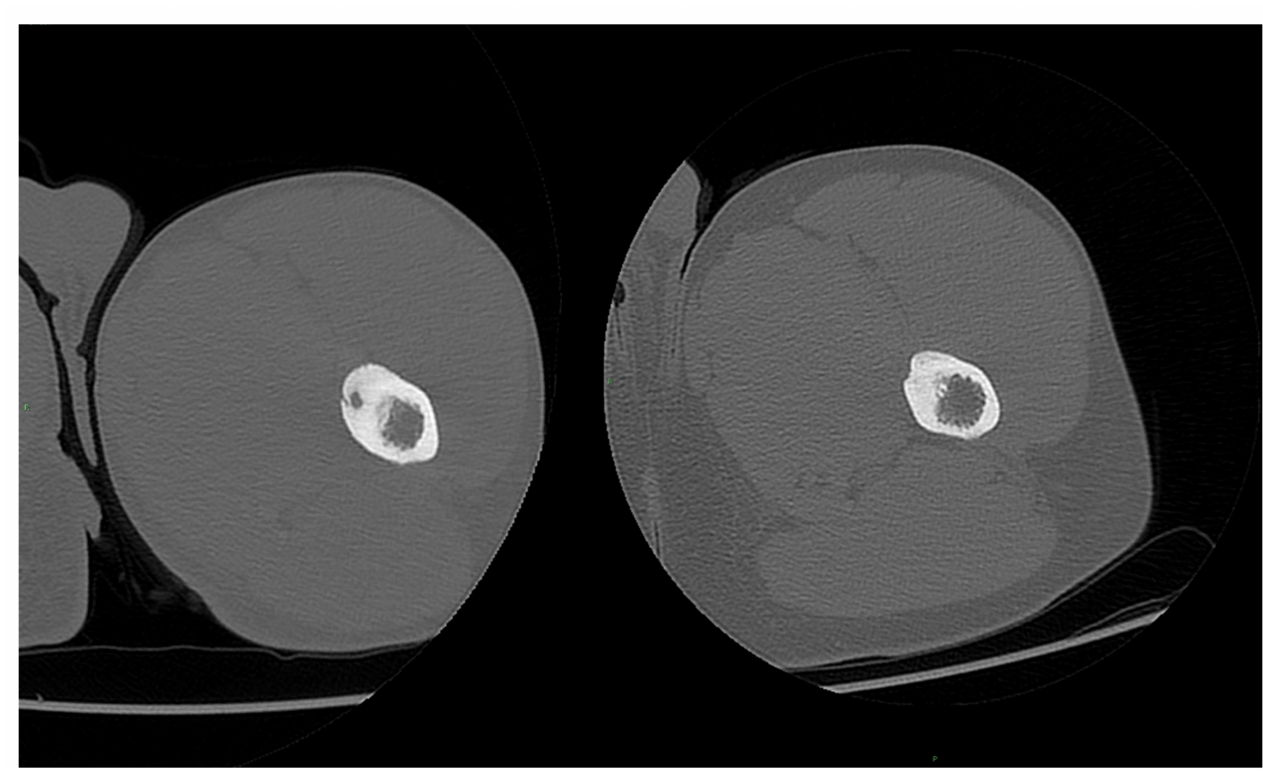
Figure 7. An OO of the proximal diaphysis of the femur in a 19 year-old boy treated successfully with MRgFUS. A complete restitution ad integrum was observed (follow-up time: 18